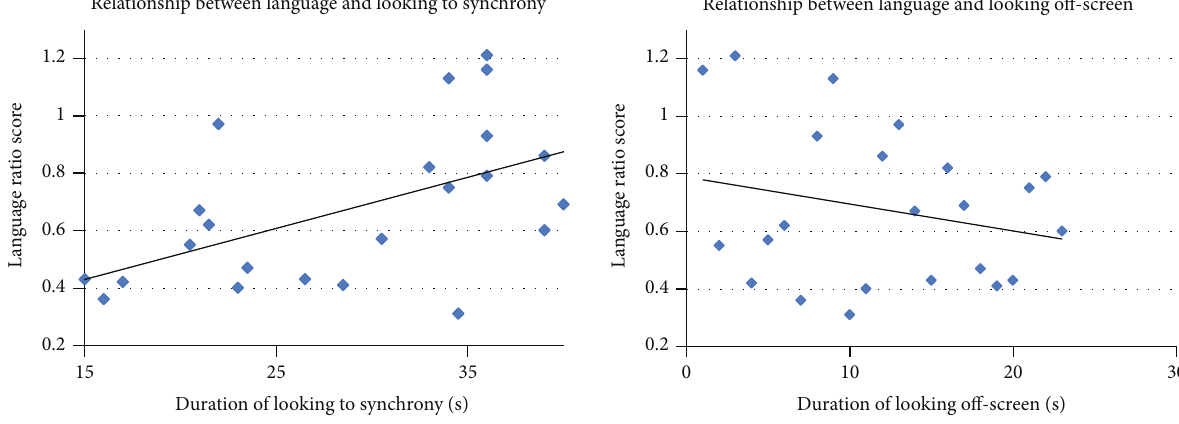
Figure 2: Language as a function of looking